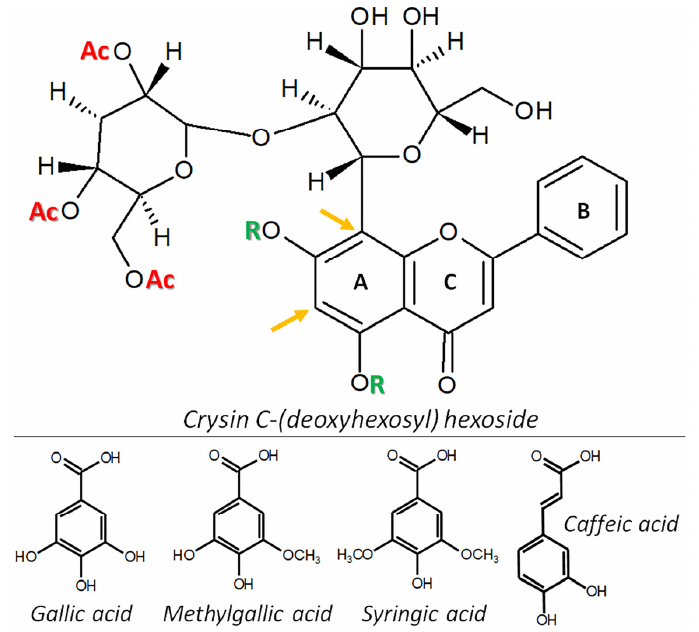
Figure 5. Proposed core structure for chrysin derivatives in Oncidium sotoanum . The chrysin flavone is linked to a hexose via a CC bond. This sugar residue is, in turn, attached to a deoxyhexose. Ac = potential sites of acetylation and acylation with syringic or gallic acid. The orange arrows highlight possible positions of the C-bond between the sugar residue and chrysin (6-C or 8-C of the flavone A ring). R = possible esterification sites with a sugar that can be acylated with caffeic, gallic and methylgallic acid.